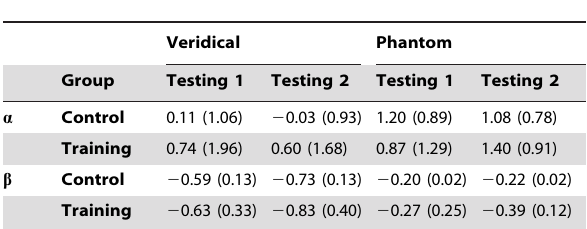
Table 1. The mean and SD (in parentheses) for a (point of subjective equality) and b (sensitivity) for veridical and phantom trials over the 1 st and 2 nd testing sessions split over the groups.